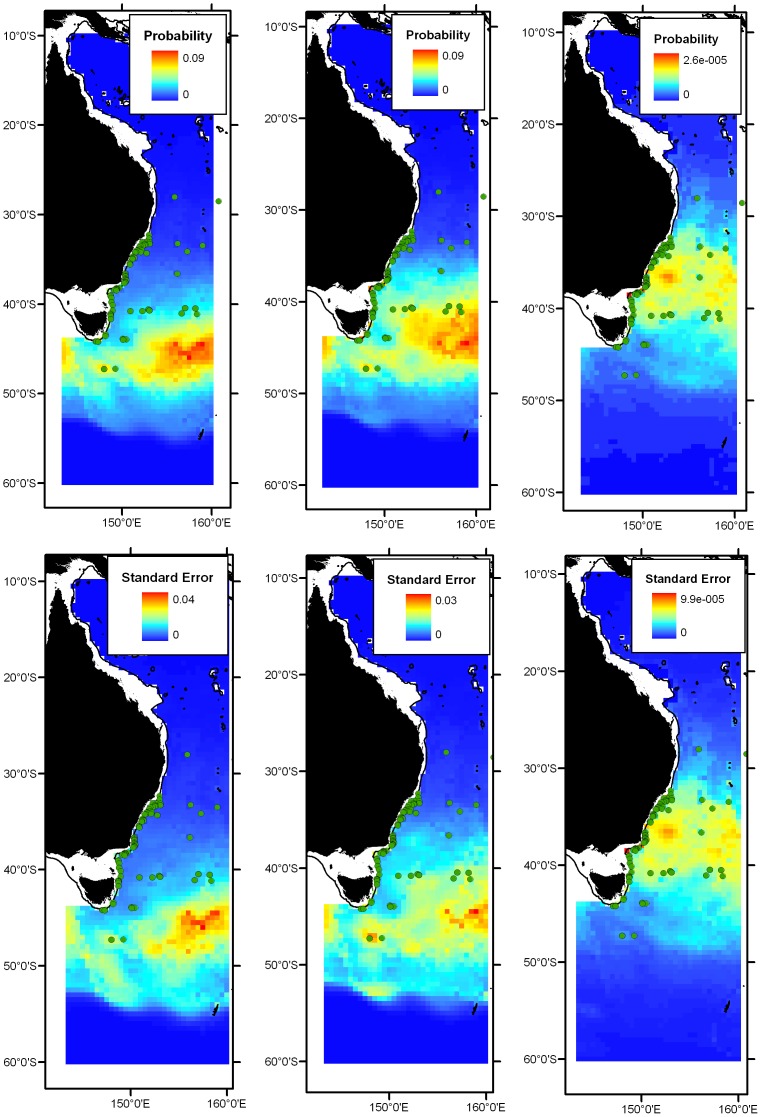
Predicted distributions of Electrona risso (top row) and standard errors (bottom row).From left to right: 0 m, 150 m and 500 m depth envelopes. Green dots indicate all occurrence records of E. risso.